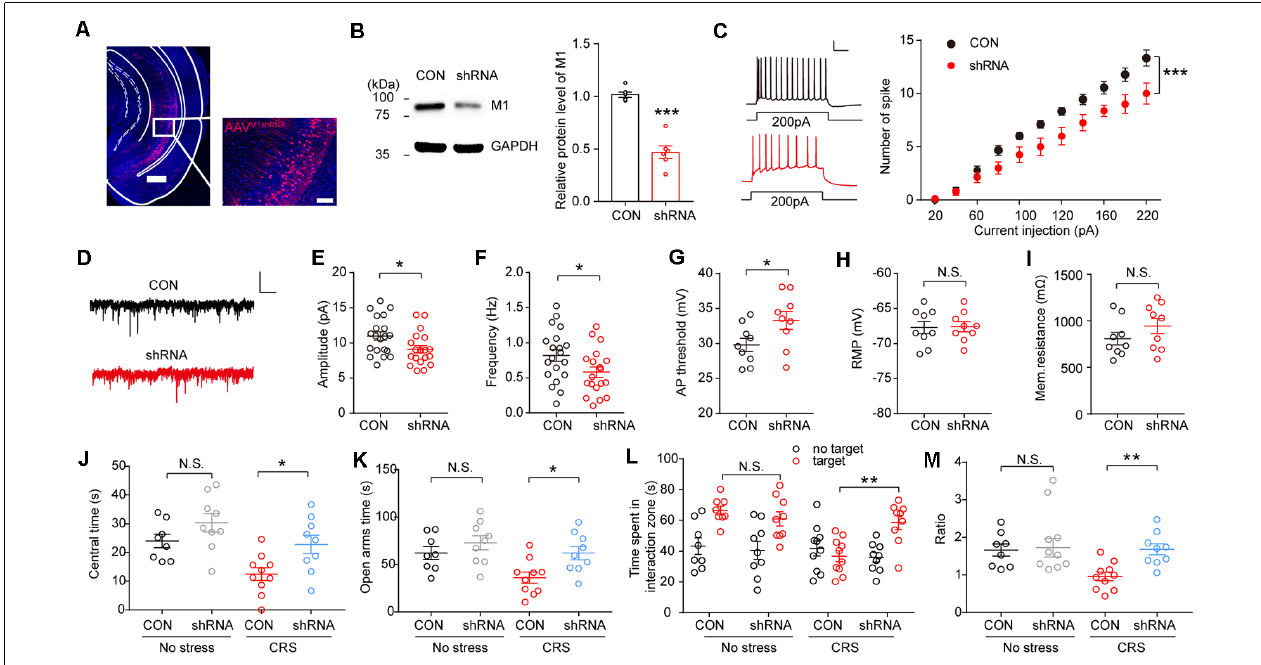
FIGURE 5 | M1 knockdown in the vHPC reverses anxiogenic effect of CRS. (A) Representative confocal images of AAV-U6-M1shRNA-CMV-RFP (red) distribution in the vHPC. Scale bar, 500 µ M; inset, 100 µ M. (B) The protein levels of M1 were decreased in the vHPC of mice injected with an AAV expressing M1-shRNA. Unpaired two-tailed Student’s t -test, t (10) = 7.269, p < 0.001. (C) Left, spikes elicited after 200 pA current injection in vHPC neurons. Scale bar, 20 pA, 100 ms. Right, spikes elicited in vHPC neurons in response to current injection. Two-way ANOVA/LSD post hoc test. F (1,264) = 47.91, p < 0.001. (D) Representative spontaneous excitatory postsynaptic currents (sEPSCs) traces of neurons in vHPC. (E,F) M1 knockdown decreased sEPSCs amplitude (E) , Unpaired two-tailed Student’s t -test, t (36) = 2.241, p = 0.0313, and frequency of vHPC neurons. Unpaired two-tailed Student’s t -test, t (36) = 2.039, p = 0.0489. (G–I) a.p. threshold, resting membrane potential (RMP) and membrane resistance for vHPC neurons. Unpaired two-tailed Student’s t -test, t (16) = 2.16, p = 0.0463. Scale bar, 10 pA, 1 s. (J) The time spent in the center of the OFT. Two-way ANOVA/LSD post hoc test. F (1,32) = 0.5203, p = 0.4760. CRS + CON vs. CRS + shRNA, t = 2.705, p = 0.0217. (K) The time spent in the open arms of the elevated plus maze (EPM). Two-way ANOVA/LSD post hoc test. F (1,32) = 1.243, p = 0.2732. CRS + CON vs. CRS + shRNA, t = 2.784, p = 0.0179. (L) SI time in the absence or presence of a social target. Two-way ANOVA/LSD post hoc test, F (1,64) = 4.5, p = 0.0063, target CON+stress vs. target CON+stress , t = 3.547, p = 0.0044. (M) The ratio in the SI test. Two-way ANOVA/LSD post hoc test. F (1,32) = 5.142, p = 0.0302. CRS + CON vs. CRS + shRNA, t = 3.04, p = 0.0094. The data are presented as the mean ± SEM, N.S.: not significant, * p < 0.05, ** p < 0.01, *** p < 0.001. The numbers of mice are shown in